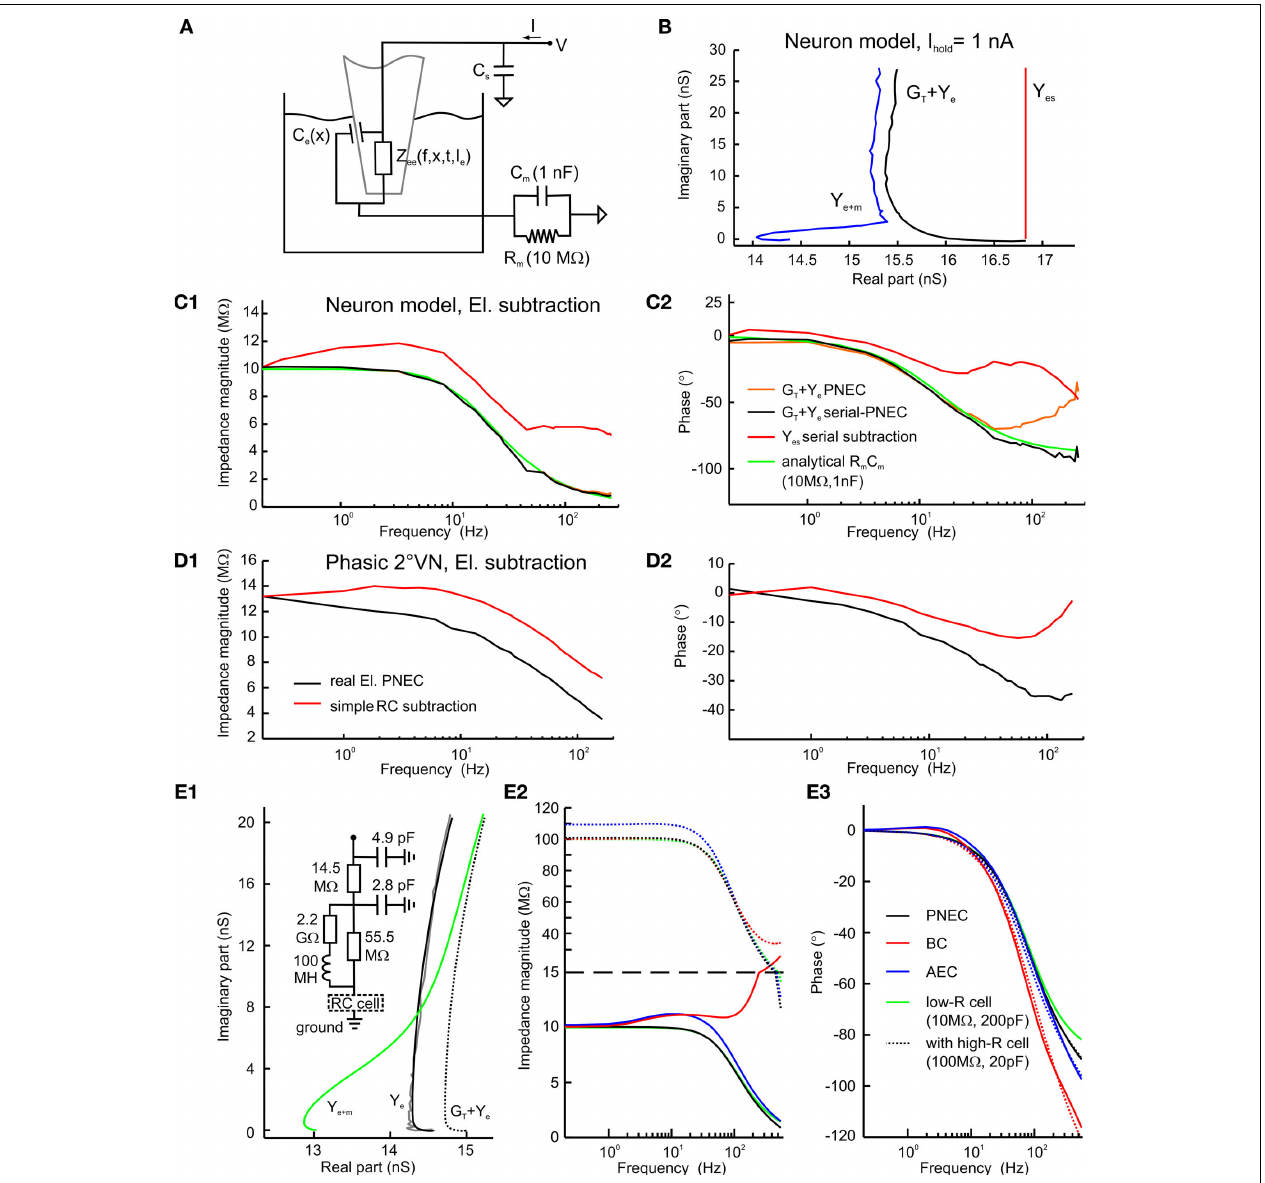
FIGURE 3 | Model test of the Piece-wise Non-linear Electrode to (C1) . (D1,D2) Results from the subtraction of a simple RC-type electrode Compensation (PNEC) method. (A) Equivalent circuit diagram of the test (red lines) and using PNEC with the actual electrode (black lines) on the setup with the electrode in the Ringer-fi lled recording chamber representing a intracellular records of a phasic 2 ° VN; note that subtraction of a simple RC-type parallel impedance Z ( f , x , t , I ) and a capacitance, C ( x ), serial to a passive electrode also shows an incorrect resonance for the actual neuron that is caused ee e e neuronal circuit model ( R = 10 M Ω , C = 1 nF) attached to the electrical path- by the above electrode artifact; trace labels in (D1) apply also to (D2) . (E1) Time- m m to-ground and a constant amplifi er stray capacitance, C , parallel to the model. domain simulation of PNEC, AEC and BC; admittance plots of an electrode with s + Y (B) Admittance plots of the corrected electrode alone G (black line) of the distributed capacities and parallel resistance and inductance (inset) Y (black line) T e e electrode with an attached neuronal circuit model Y (blue line) and the with parameters adjusted to mimic the behavior as measured in real electrodes e + m analytical response of a simple RC-type electrode model Y (red line); (gray line), with an attached passive RC neuronal circuit model (10 M Ω , 200 pF) es + Y I = + 1 nA, plotted frequency spectrum 0.2–485 Hz. (C1,C2) Bode plots of a (green line) and shifted electrode G and reduced overall resistance Y hold e + m T e + m passive neuronal circuit model using different electrode compensation methods (dotted line) prior to PNEC subtraction; plotted frequency spectrum 0–556.2 Hz. + Y on the combined measurement Y : (a) electrode G (orange lines) with (E2,E3) Results after electrode compensation with a low resistance RC cell e + m T e + Y PNEC, (b) electrode G using serial-PNEC (black lines), (c) simple theoretical (low-R: 10 M Ω , 200 pF) (solid lines) or a high resistance RC cell (high-R: 100 M Ω , T e RC electrode, Y , using serial subtraction (red lines) and (d) the analytical 20 pF) (dotted lines): simple BC (red) or AEC compensation (blue) causes es passive neuronal circuit model (green lines). Note that using the simple RC electrode resonance artifacts in the impedance (E2) and phase (E3) , while PNEC electrode compensation for the passive neuronal model shows a resonance (black) complies well with the expected results (green); change of y -coordinate that is solely an electrode compensation artifact; trace labels in (C2) also apply scale at 15 M Ω (dashed line) in (E2) ; trace labels in (E3) also apply to (E2)